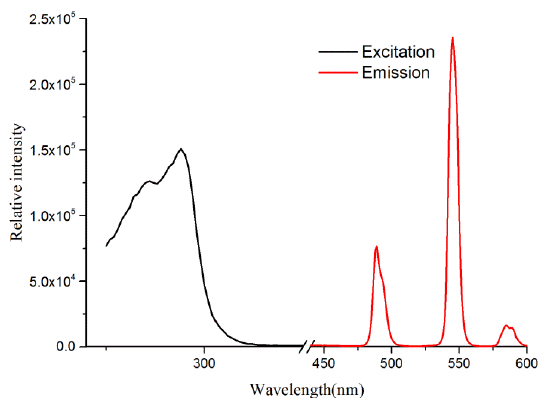
Nanomaterials 2018 , 8 , x FOR PEER REVIEW Figure 5. The excitation (dashed) and emission (solid) spectra of the Tb(3+)@Sr-MOF.